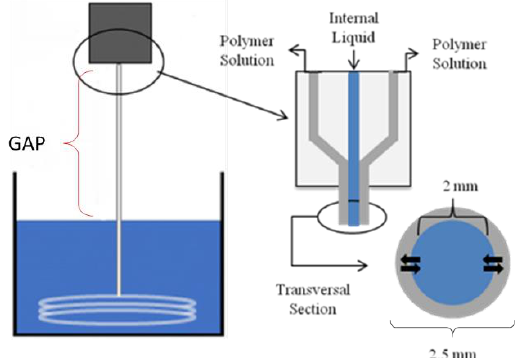
Figure 3. Schematic representation of the extruder for the production of hollow fiber membranes.